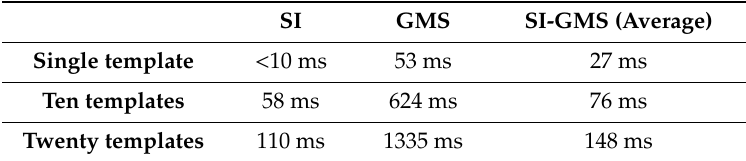
Table 4. Comparison of the execution time.